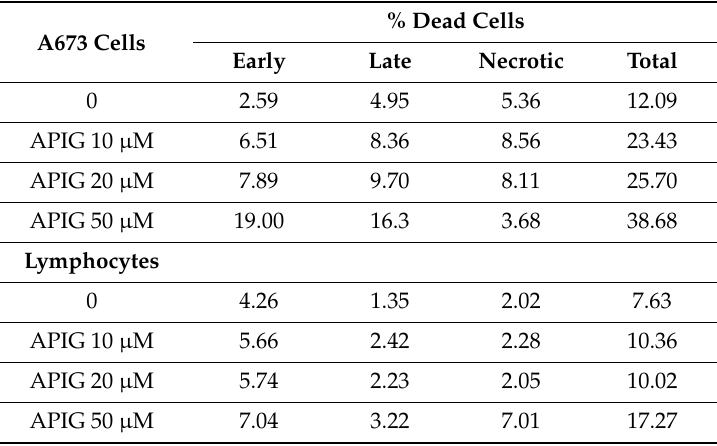
Table 1. Percentage of early apoptotic, late apoptotic and dead cells expressed by the annexin V assay in A673 cells and normal lymphocytes. APIG: apigenin .